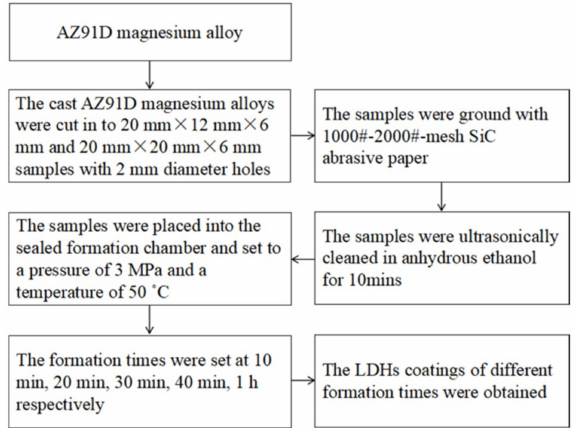
Figure 1. Preparation flowchart of the layered double hydroxides (LDHs) coating prepared by CO 2